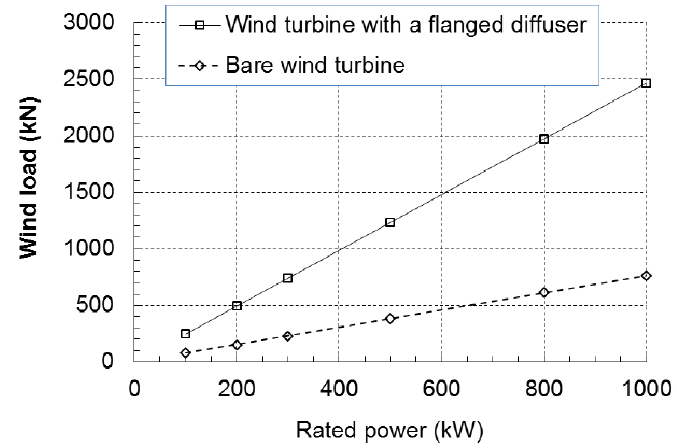
Figure 2. Wind loads acting on two kinds of wind turbines with and without a flanged diffuser at 60 m/s for various rated